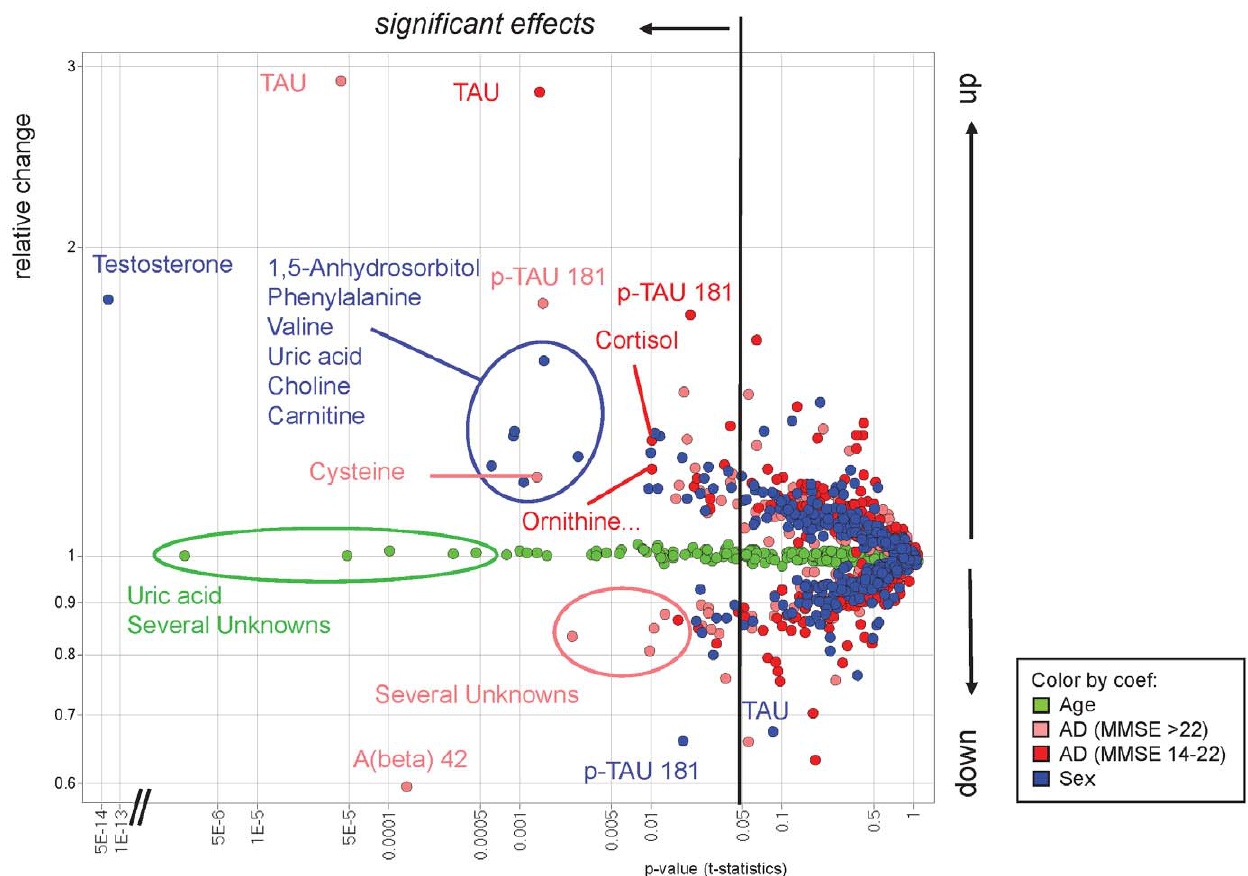
Figure 6. Significance levels and relative changes with respect to influencing factors gender, age and disease status (light AD; strong AD) are shown. All SQ 343 analytes measured by metabolite profiling, and the proteins TAU, p-TAU 181 and amyloid beta 42 were included in the linear modeling calculation. In the case of gender-related correlations (blue circles) relative changes . 1 indicate increased levels in males compared to females (logarithmic scale for both axes; relative change for age-related effects are not-to-scale).